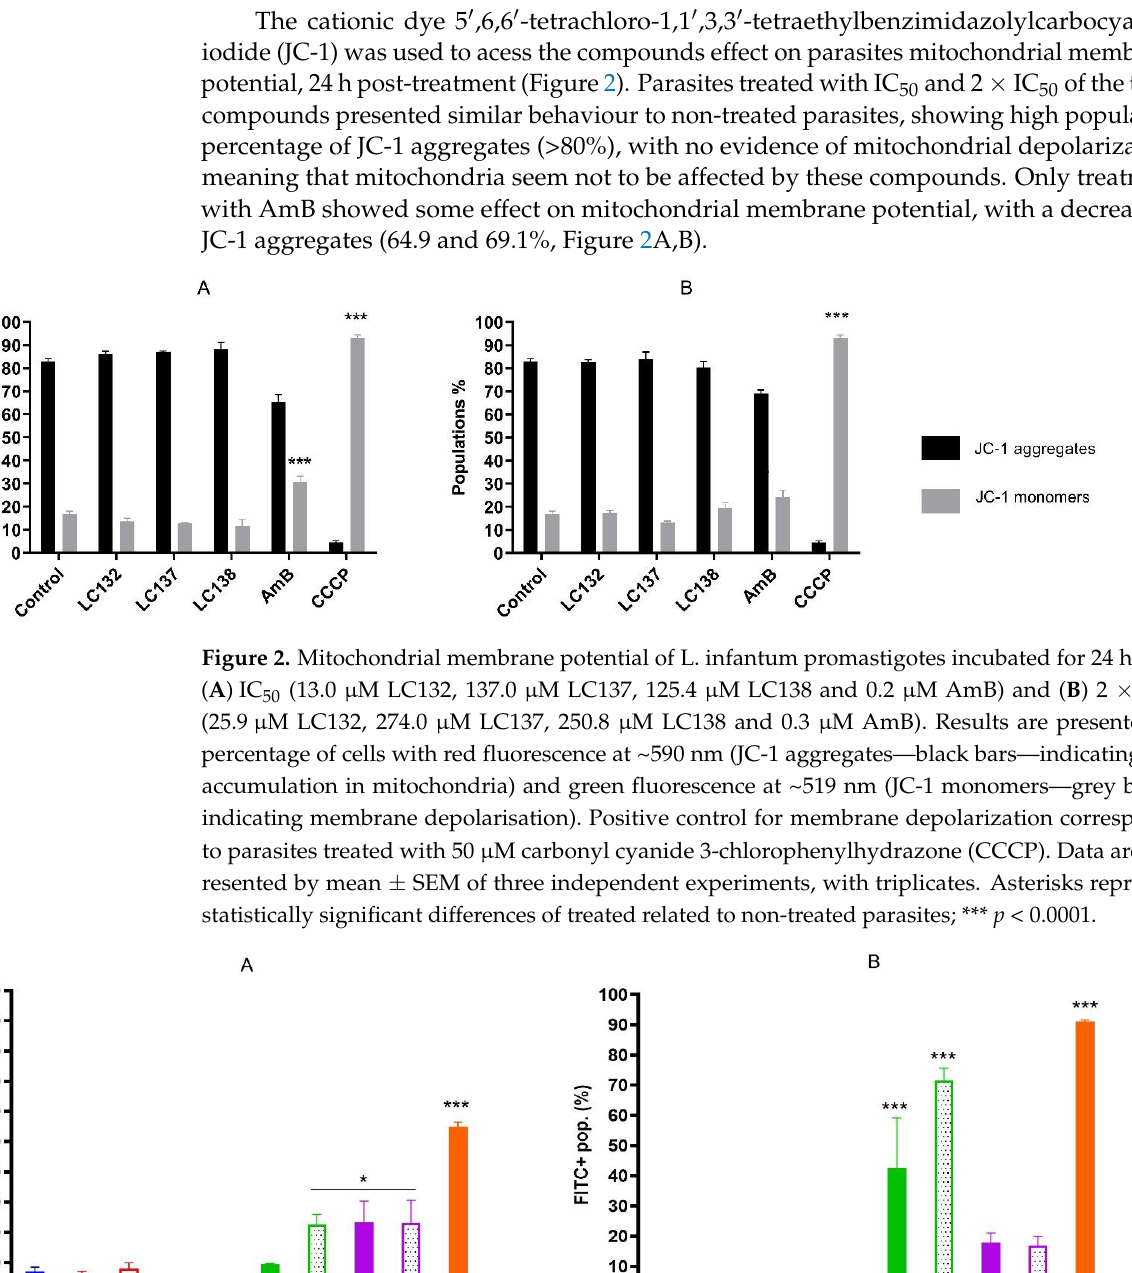
Figure 1. Flow cytometry analysis of phosphatidylserine externalization after 24 h ( A , B ) and 48 h ( C , D ) treatment of L. infantum promastigotes with IC 50 LC132 (13.0 µM), LC137 (137.0 µM), LC138 (125.4 µM) or AmB (0.2 µM) and 2 × IC 50 LC132 (25.9 µM), LC137 (274.0 µM), LC138 (250.8 µM or AmB (0.3 µM). Percentages correspond to Annexin V (Annex) and Propidium iodide (PI) cell pop-